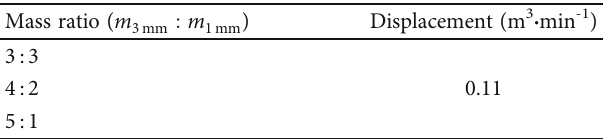
Figure 5: The migration trajectory in the wellbore of 3mm and 1 mm mixed particles. (a) Schematic diagram of particles migration. (b) Particles migration trajectory at C1. (c) Particles migration trajectory at C2. (d) Settling of mixed temporary plugging particles in the perforation. Table 2: Multiple particle size combination experiment